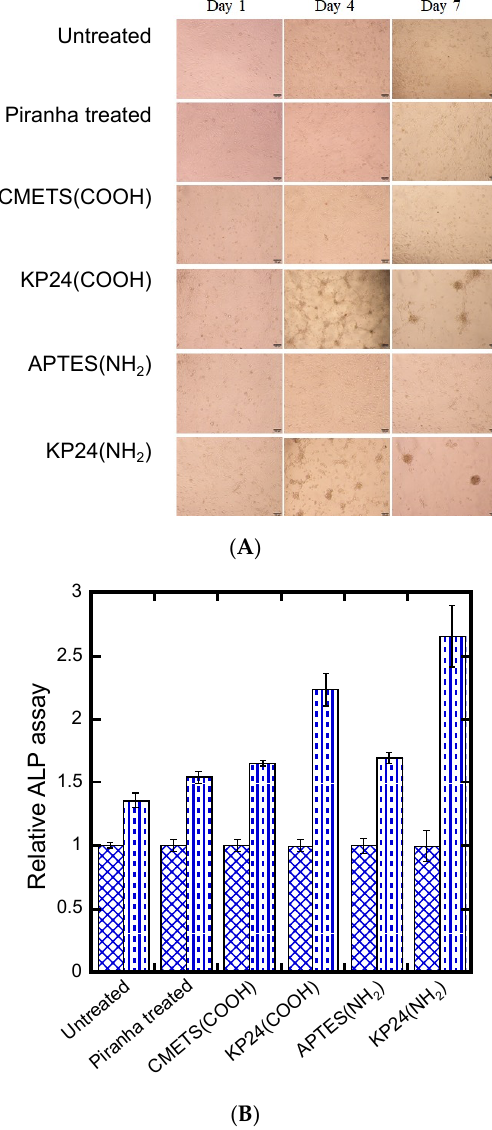
Figure 5. Induction of hMSC cell aggregates on KP24-immobilized substrate. ( A ) Microphotographs of hMSC cell aggregates in various substrates. Incubation time: 1, 4, 7 days. ( B ) ALP assay of induced differentiation into osteoblasts in various substrates ( n = 4). Incubation time: 1, 4 days.